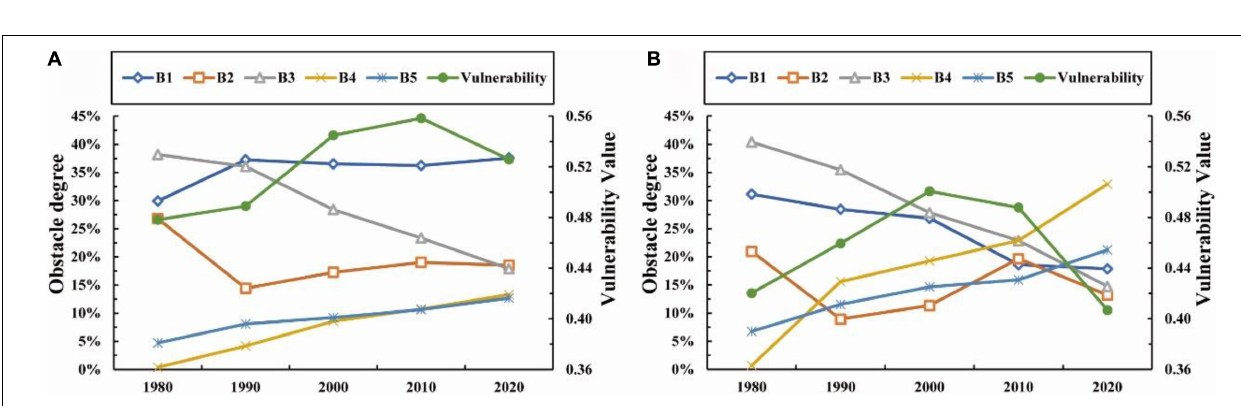
Frontiers in Marine Science |